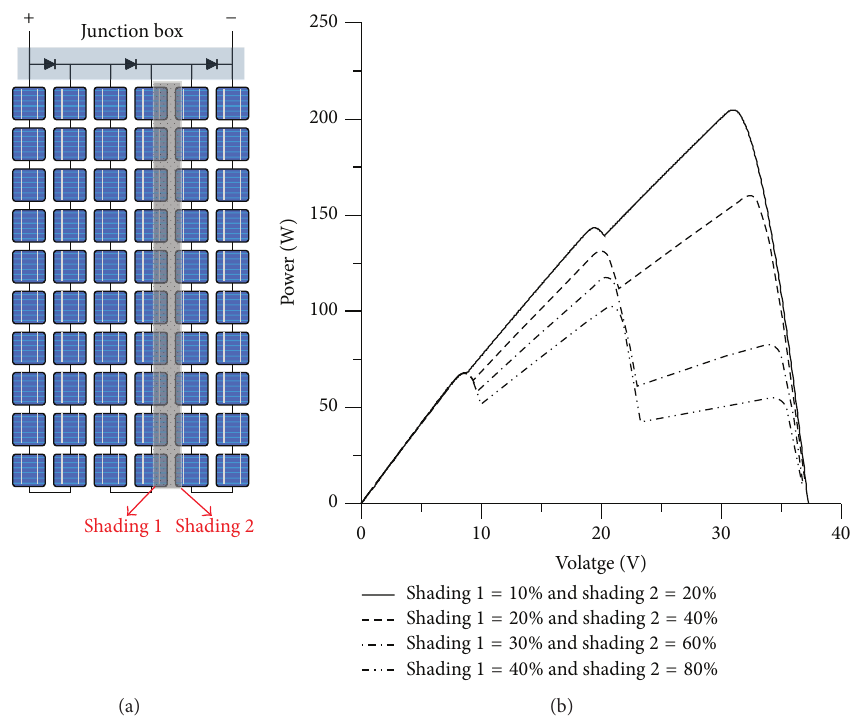
Figure 5: Power voltage characteristic curves for SG-2300 PV panel with various shading conditions over two of the three zones, 𝑇 = 25 ∘ C.